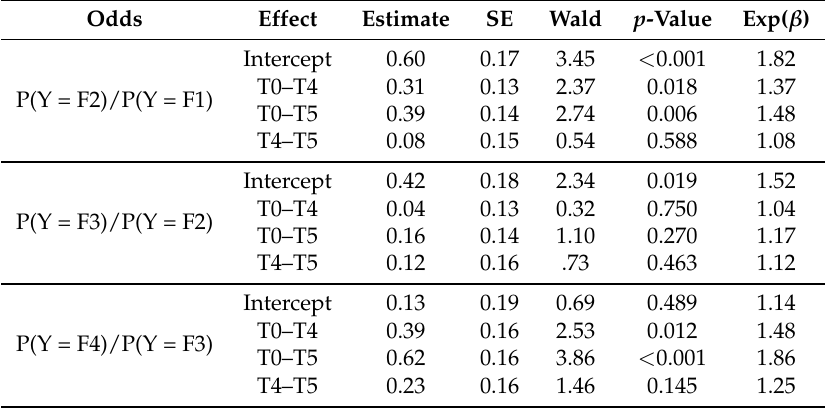
Table 3. Multinominal regression coefficients of the time of measurement